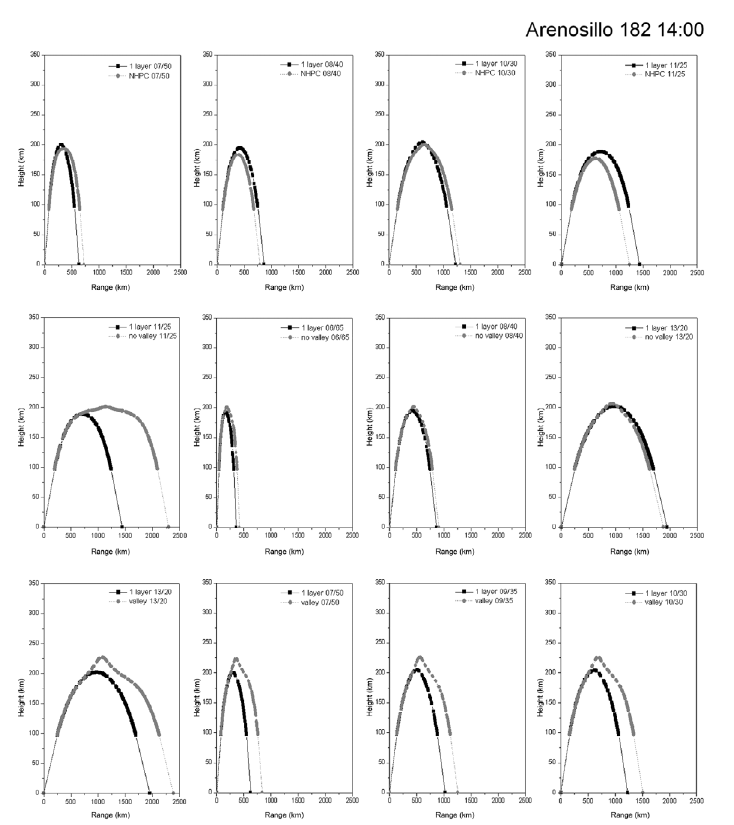
Fig. 4. Worst cases for the range values differences during the ionospheric conditions described by fig.